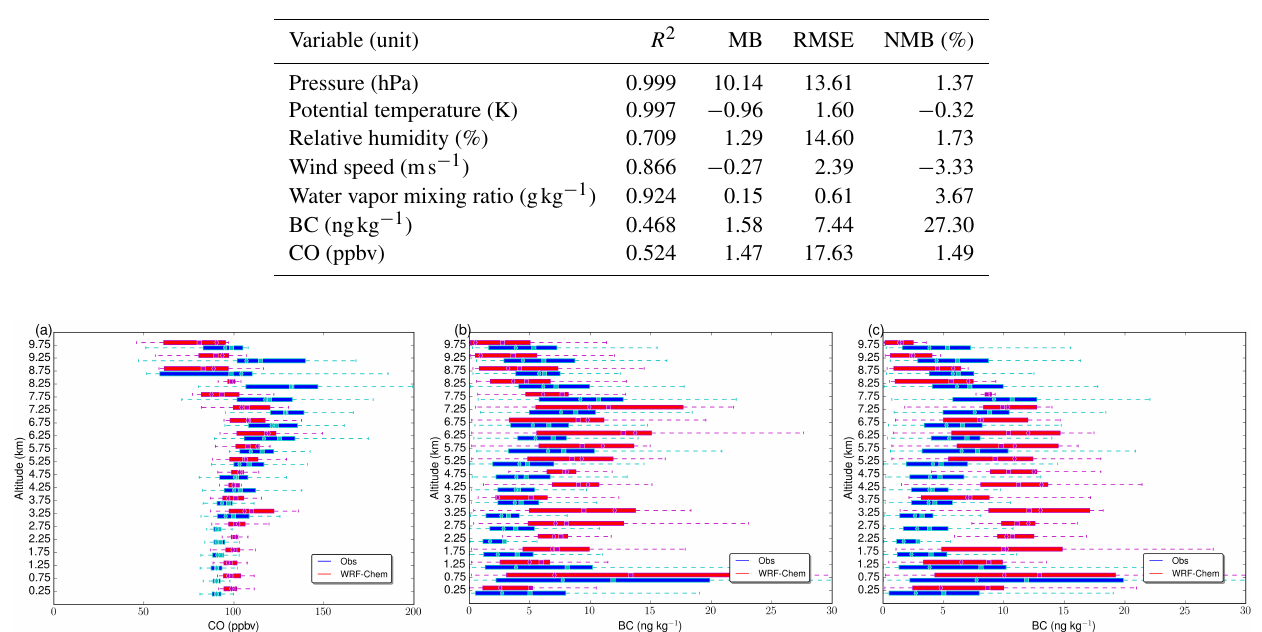
Figure 3. Vertical profiles of observed (blue) and modeled (red) mixing ratios of (a) CO (ppbv), (b) BC (ngkg − 1 ) at a horizontal resolution 40km (BASE), and (c) BC (ngkg − 1 ) at a horizontal resolution 100km (Run100) interpolated along all the 14 Falcon flight tracks. Boxes represent the interquartile range, diamonds are the median values, squares show the means and whiskers show the minimum and maximum of the